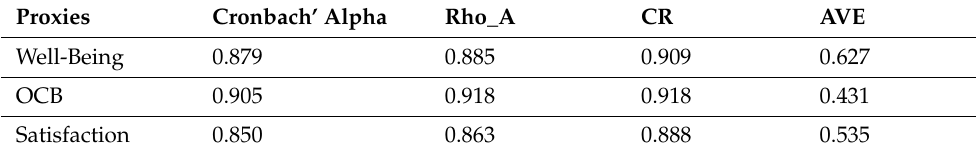
Table 2. Internal consistency and convergent validity of Sustainable Careers proxies. Proxies Cronbach’ Alpha Rho_A CR AVE Well-Being 0.879 0.885 OCB Satisfaction 0.850 0.863